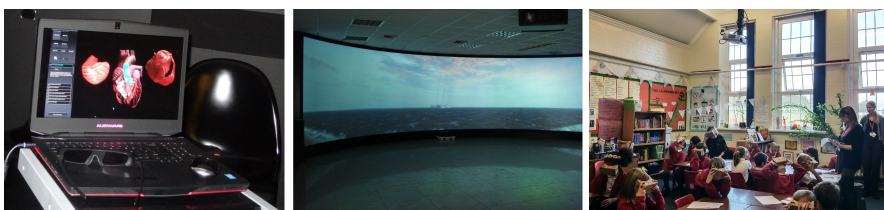
Figure 1. Different types of VR used for the purpose of education. From left: VR environment using common mouse/keyboard on a stereoscopic display [39], Experience room used to show tsunami